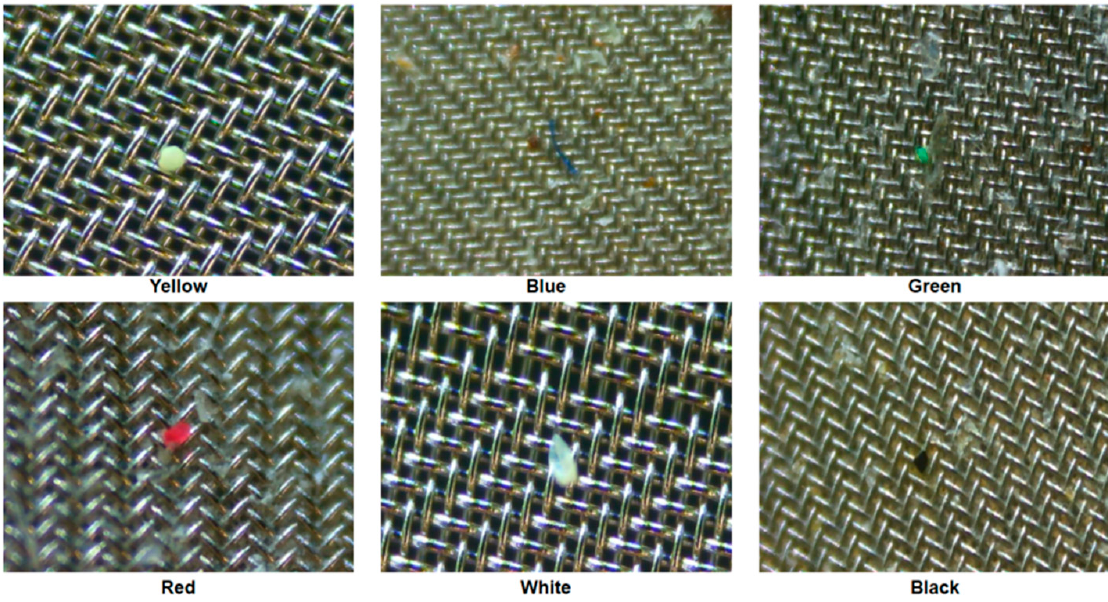
Figure 5. Color confirmation of microplastics using a digital microscope.